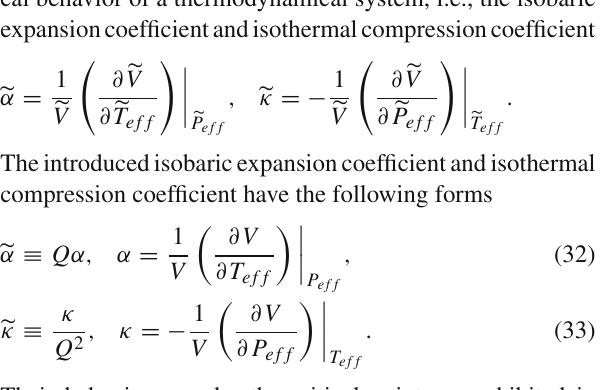
. The parameter of Q 2 / l 2 is set to 1 eff